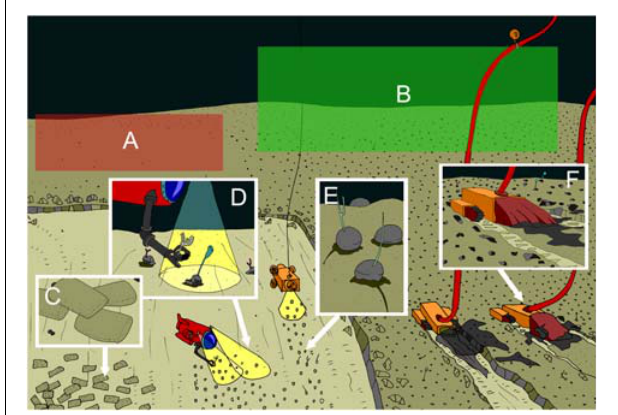
FIGURE 2 | Overview figure (Courtesy of Autun Purser) showing examples of mitigation and restoration actions for the nodule fields ecosystem, with (A) a less suitable set-aside area featuring different nodule densities than the mined area, (B) a more suitable set-aside area featuring nodule densities similar to the mined area. To limit the plume extent, waste sediments (post-processing) can be returned to the deep-sea surface in e.g., as fast sinking bricks, or biodegradable bags and/or in the shape of nodules (C) . (D) Faunal transplants and (E) artificial colonisation substrata (in this case artificial nodules (hard substrata) and artificial sponge stalks) are recurrent proposed restoration actions. Clever engineering or vehicle design can limit primary plumes, e.g,. light-weight vehicles equipped with shrouds (F) .